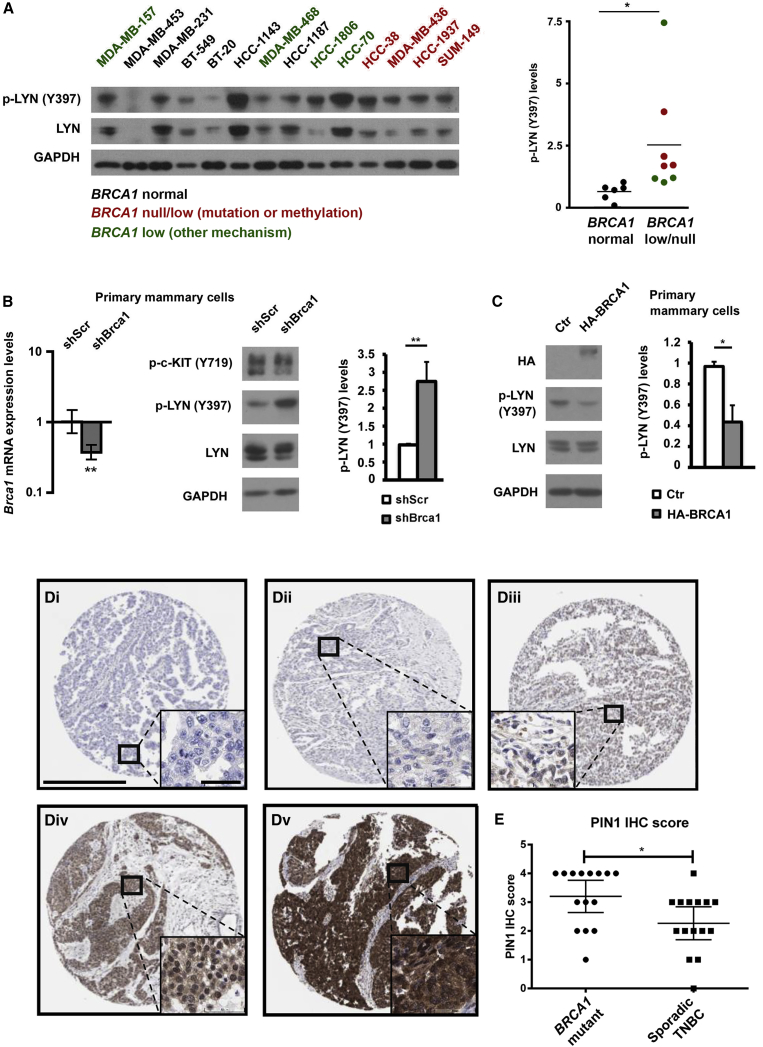
LYN Activity Is Regulated by BRCA1 via the Prolyl Isomerase PIN1(A) Protein extracts from TNBC cells with either wild-type BRCA1 or impaired BRCA1 expression were analyzed for phospho-LYN (p-LYN) (Y397), total LYN, and GAPDH levels by western blot. Scatterplot shows quantification of p-LYN levels normalized to total LYN levels.(B) Primary mouse mammary organoids were transduced with control (shScr) or Brca1 knockdown (shBrca1) lentiviruses. Knockdown was assessed by qRT-PCR relative to comparator shScr cells (left). shScr and shBrca1 cells were assessed for levels of phospho-c-KIT (Y719), phospho-LYN (Y397), LYN, and GAPDH by western blot after 4 days (middle).(C) Western blot analysis and quantitation of LYN autophosphorylation levels in primary mouse mammary organoids transduced with control (Ctr) or HA-tagged BRCA1 (HA BRCA1) expression lentiviruses.(D) Examples of PIN1 immunohistochemistry scores in breast cancer TMAs: (i) 0, (ii) 1, (iii) 2, (iv) 3, and (v) 4. DAB staining of PIN1, and blue counterstaining of nuclei. Scale bar in main panels, 500 μm; scale bar in inset, 50 μm.(E) Quantitation of PIN1 scoring in BRCA1 mutant and sporadic TNBC TMAs.Blots in (B) and (C) are representative of three independent experiments. Quantitation is shown as mean and SD (n = 3; two-tailed unpaired t tests) except for gene expression analysis by quantitative real-time RT-PCR (mean ± 95% confidence intervals; significance of real-time RT-PCR data was determined from confidence intervals; n = 3 independent experiments for each of 3 technical replicates per sample) (Cumming et al., 2007). ∗p < 0.05; ∗∗p < 0.01. See also Figure S4.